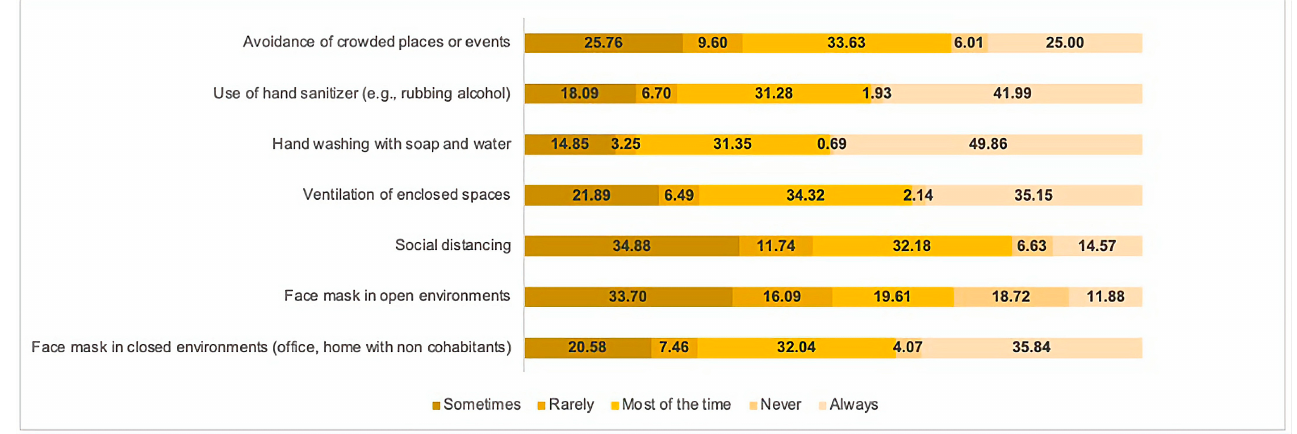
Figure 3. Non-pharmacological protective measures against COVID-19 in South America (N = 1448). Table 3. Non-pharmacological protective measures against COVID-19 and association with the Pandemic Fatigue Scale (PFS scores) (N = 1448).